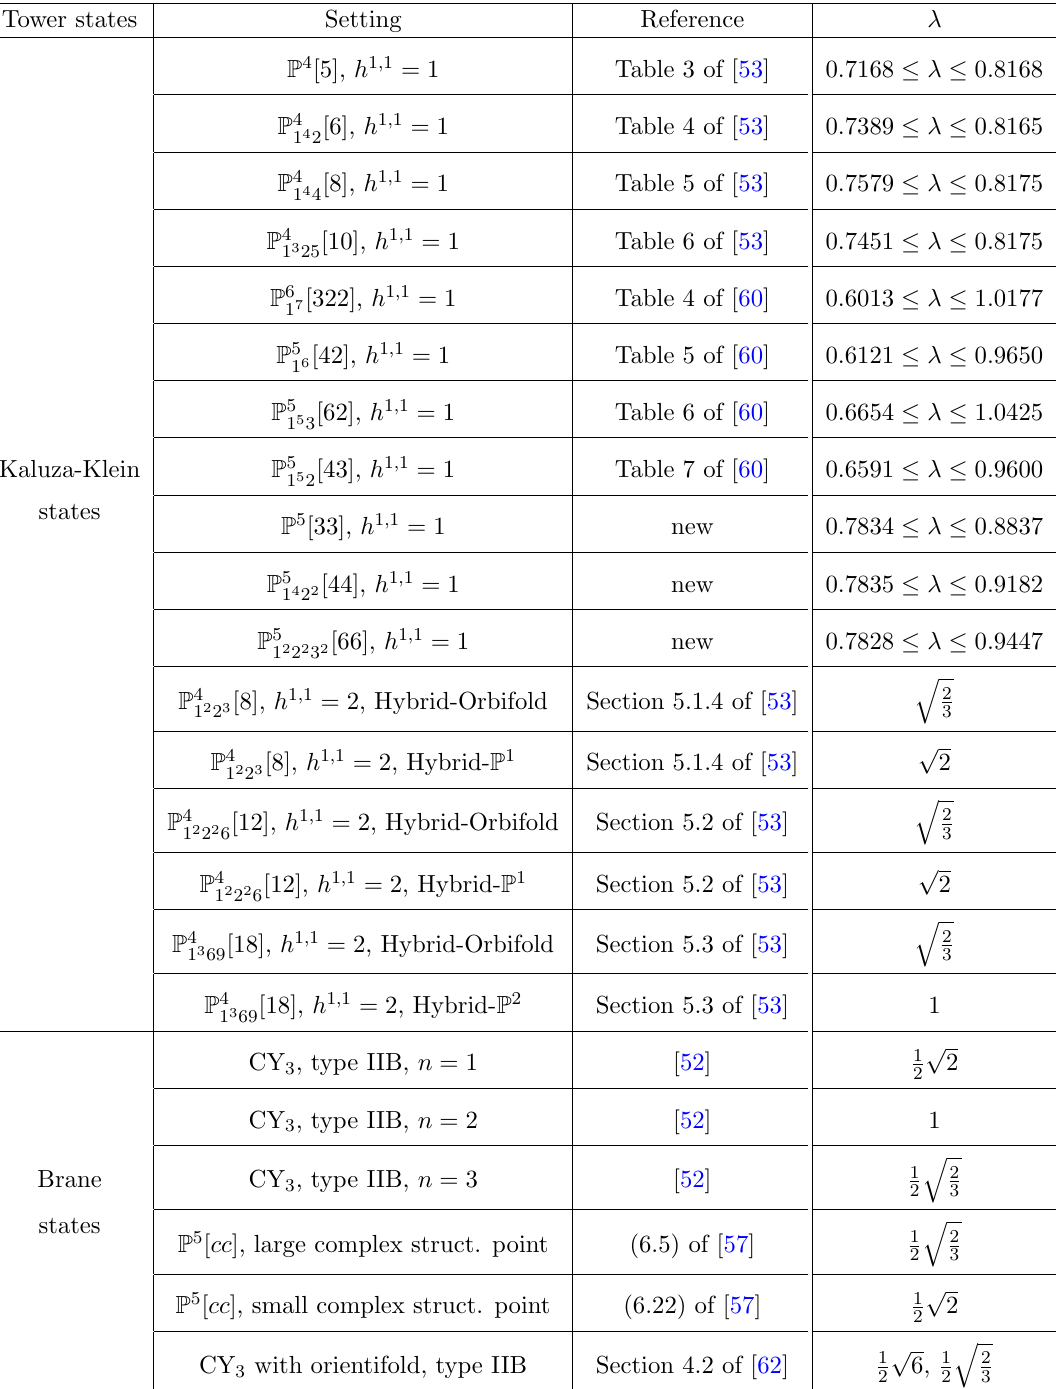
Table 3 . Values of (cid:21) in the distance conjecture (1.5) that were obtained in the literature, as well as few new ones. The states of the tower becoming massless are either Kaluza-Klein states or brane states. For each value or range of values, we give the setting in which it was obtained and the reference in the literature. More details can be found in the main text.